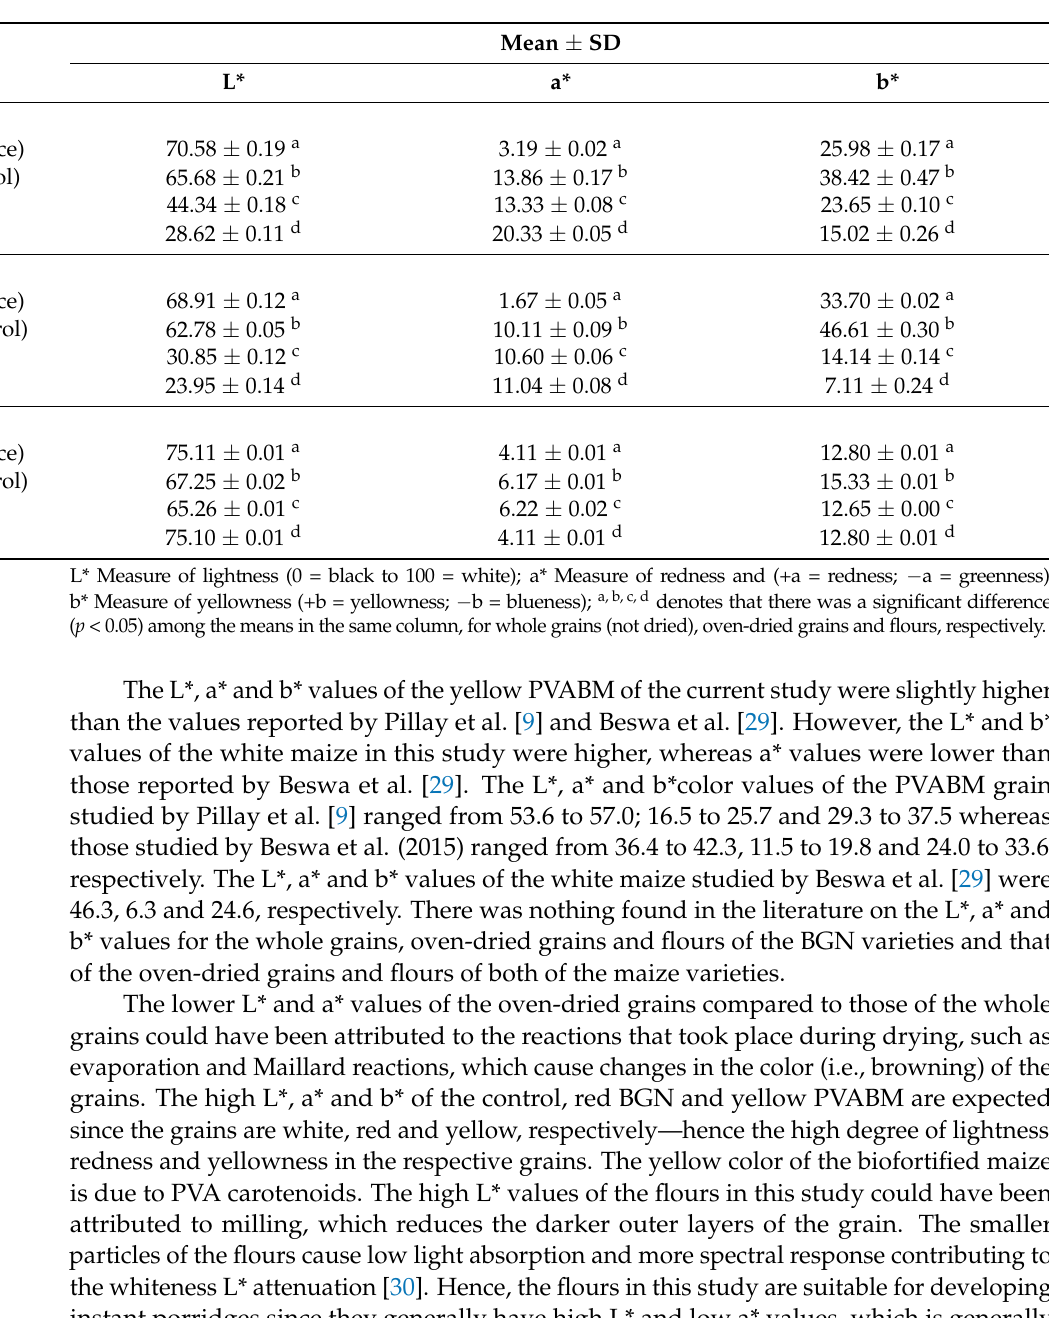
Table 2. The CIE color values (Hunter L*, a* and b*) of the whole grains, oven-dried grains and flours of white maize, PABM, brown and red BGN